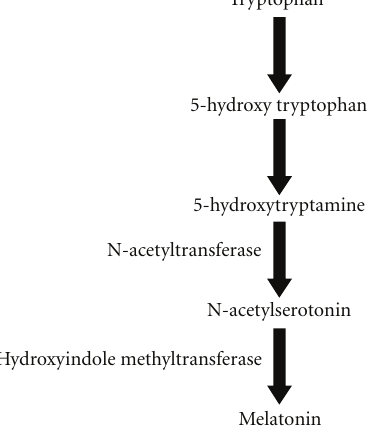
Figure 1: Biochemical steps for melatonin synthesis in pinealocyte.